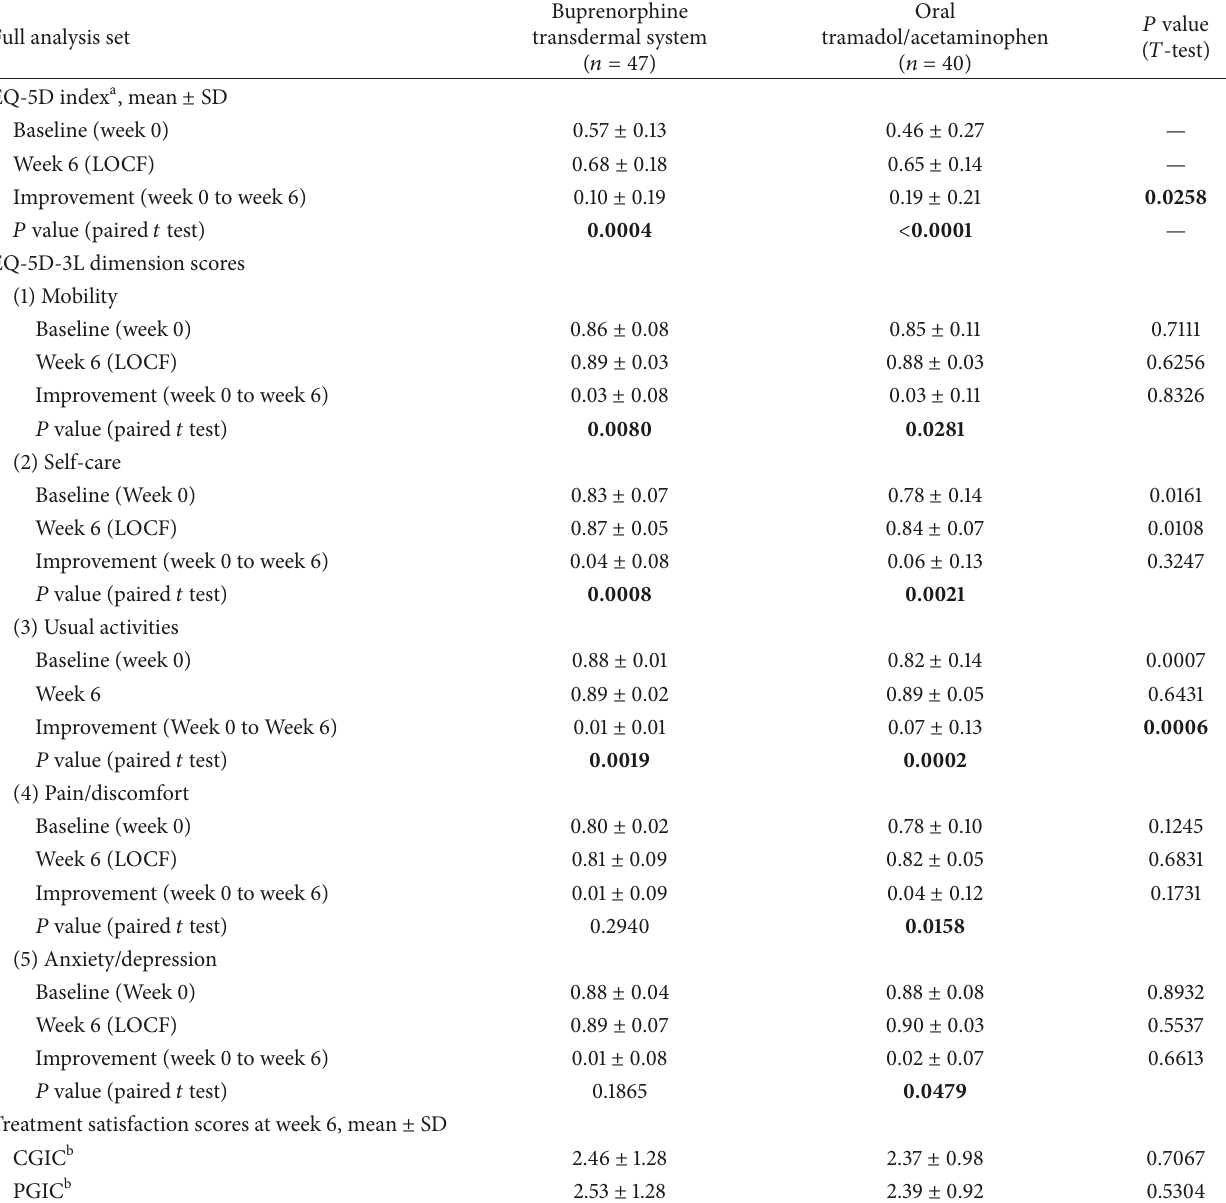
Table 3: Quality of life and treatment satisfaction